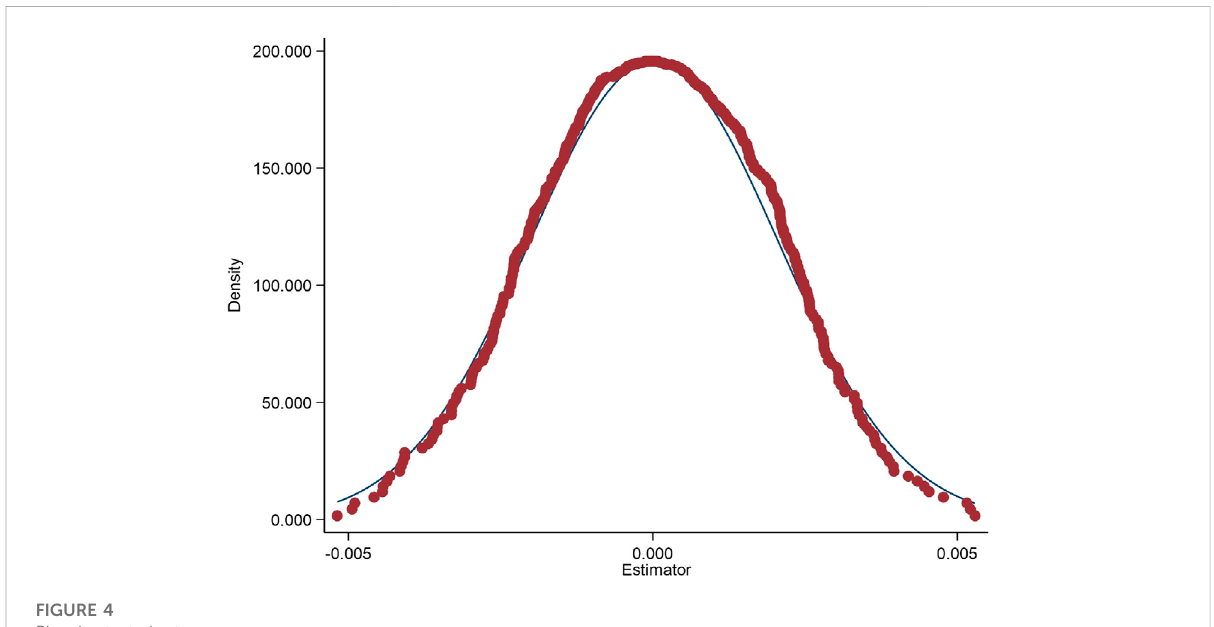
FIGURE 4 Placebo test